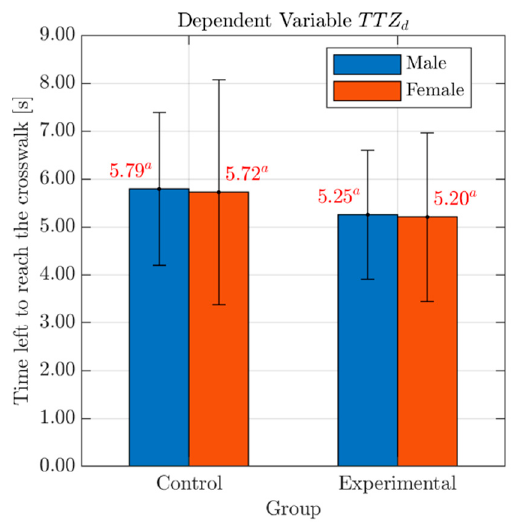
Figure 4. E ff ects of Gender and Group on the variable TTZ d . Legend : Red numbers above the bars Figure 4. Effects of Gender and Group on the variable (cid:1846)(cid:1846)(cid:1852) (cid:3031) . Legend : Red numbers above the bars represent mean values of the variable TTZ d , for males (blue bar) and females (red bar) in each Group. represent mean values of the variable (cid:1846)(cid:1846)(cid:1852) (cid:3031) , for males (blue bar) and females (red bar) in each Group. Statistically significant di ff erences are indicated by di ff erent superscript letters. Standard deviation Statistically significant differences are indicated by different superscript letters. Standard deviation error bars are also reported for each error bars are also reported for each sub-group.